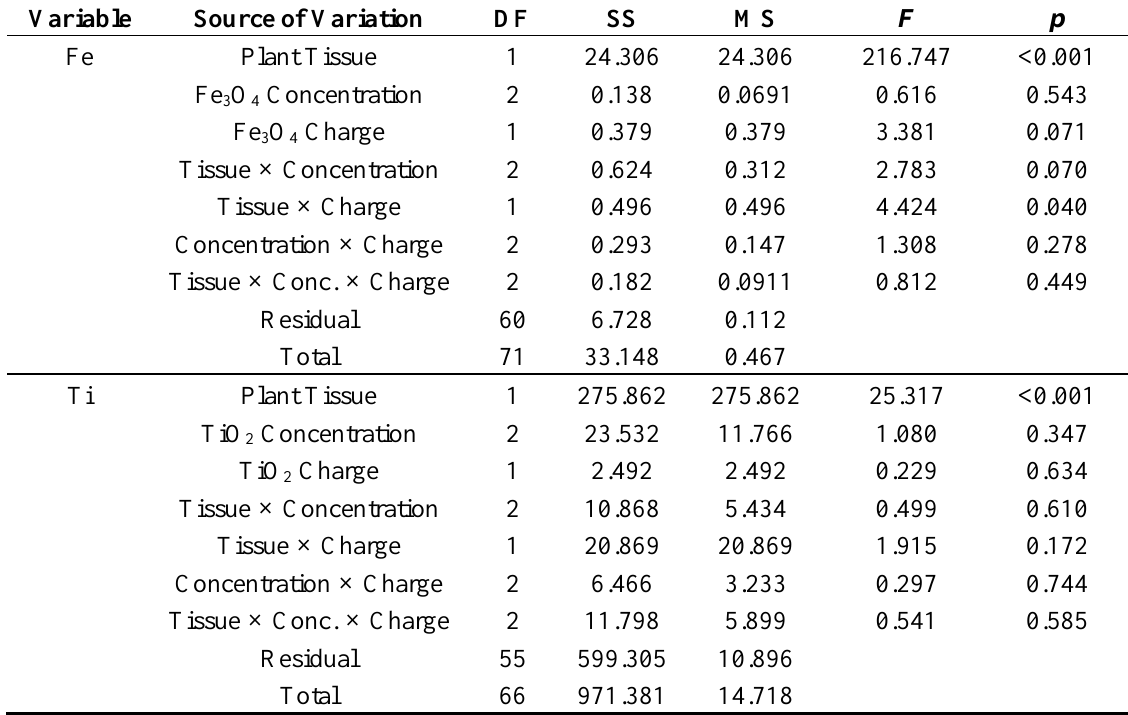
Table 3. Results of three-way ANOVA using the general linear model for effects of plant tissue (root or leaf), nanoparticle concentration, and nanoparticle charge on plant tissue metal concentrations. p values are shown where significant differences ( p < 0.1) are in bold. Data for Fe 3 O 4 were log transformed to meet normality